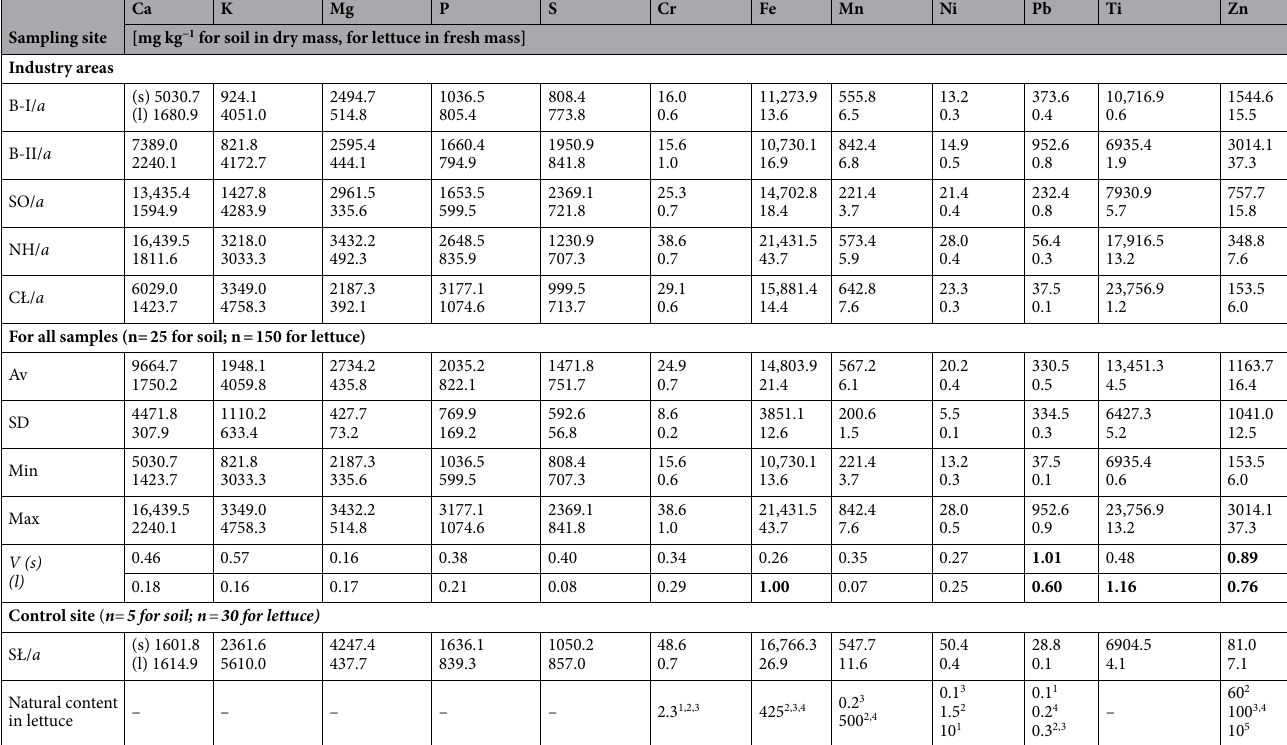
Table 1. The total content of elements in ( a ) unfertilized soil (s) and lettuce leaves (l). “ a “ index—unfertilized; (s)—data for soil samples from Kicińska and Wikar (2020), (l)—data for lettuce; “– “ lack data; V- coefficient of variation, bolded V ≥ 0.6; 1 Islam et al. 31 . 2 Tasrina et al. 39 . 3 Latif et al. 33 . 4 Ramteke et al. 40 . 5 Kabata-Pendias and Pendias 32